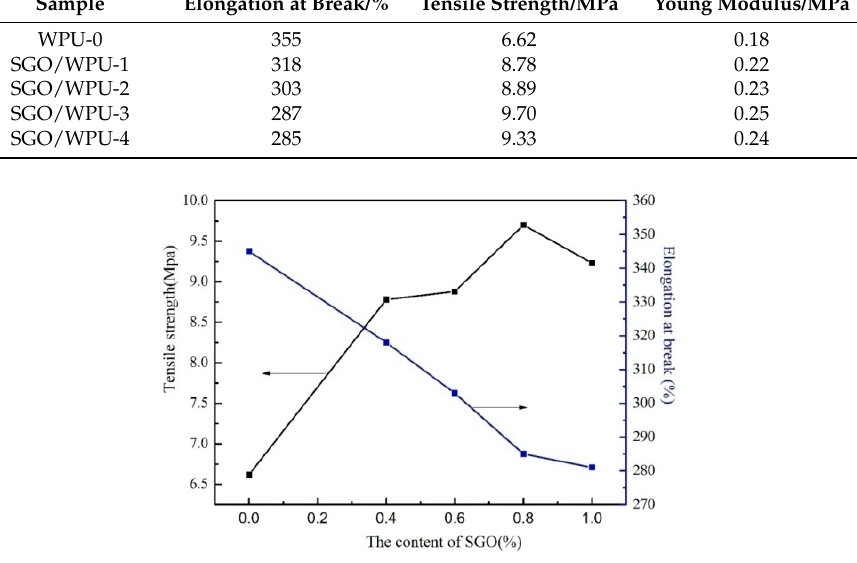
Figure 10. Mechanical properties of SGO/WPU composites with different SGO contents.